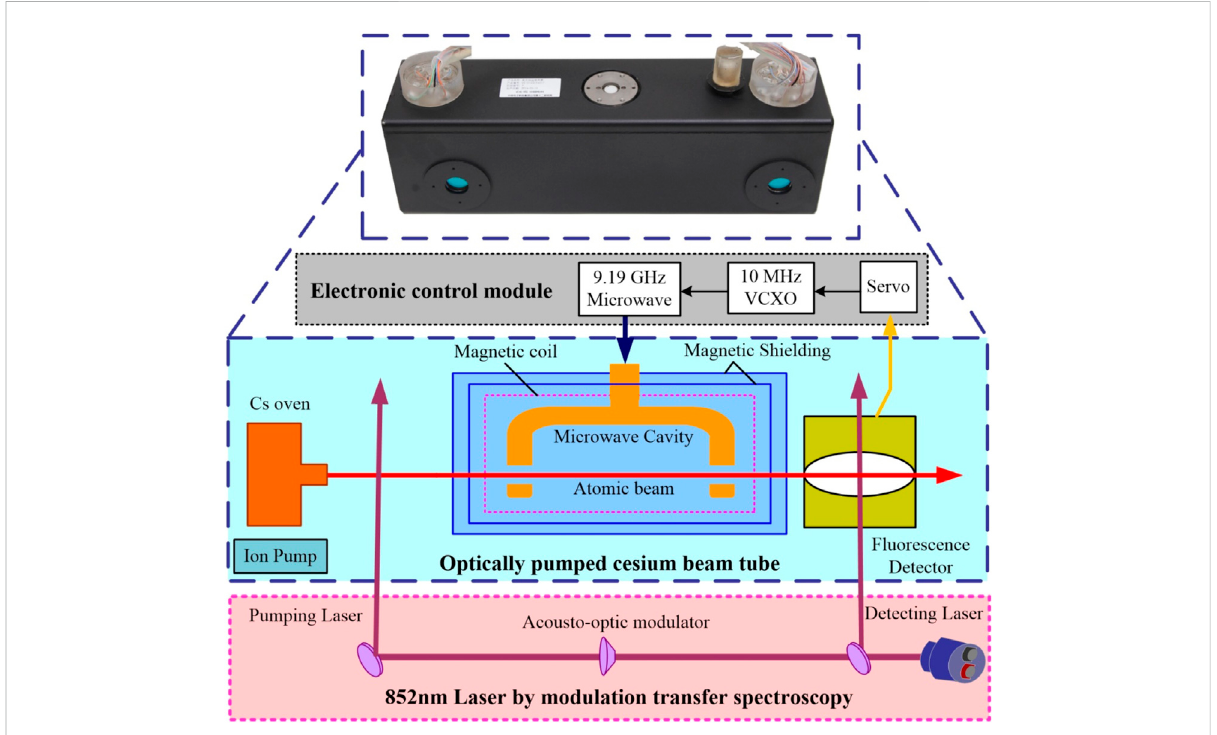
FIGURE 1 Overallcon fi gurationofthecompactopticallypumpedcesiumbeamatomicclock.ThecyanboxisthediagramofthepracticalOPCBTmadein BVERI, and the photograph is shown as above. The pink box is the 852 nm laser by MTS. The gray box is the electronic control